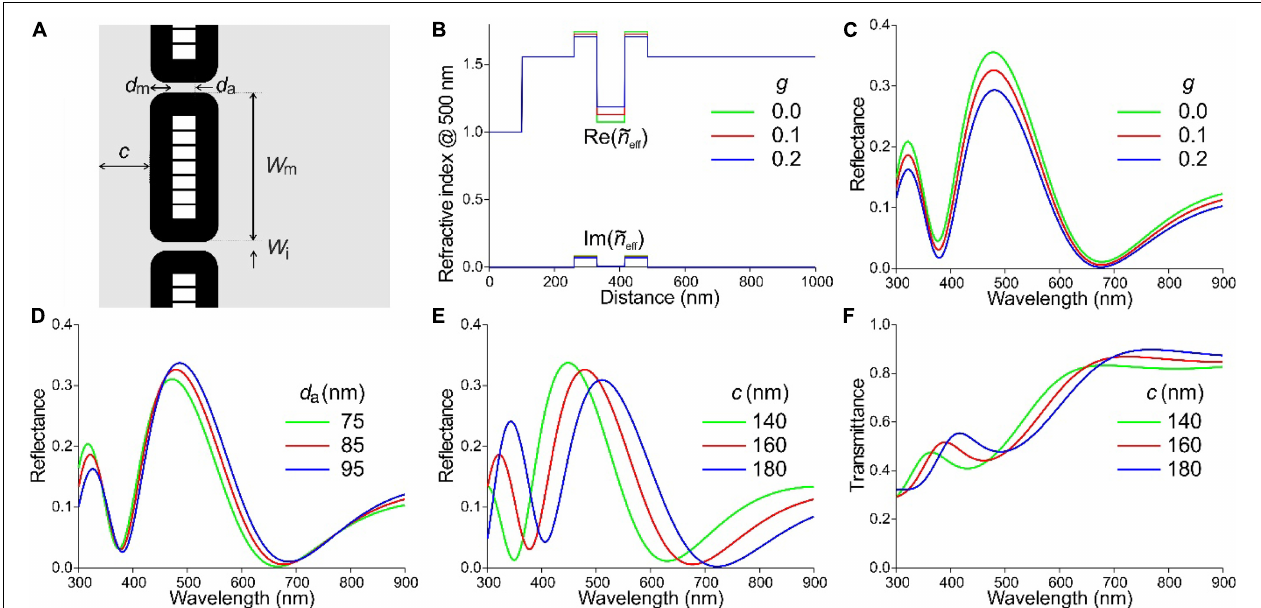
FIGURE 7 | Effective-medium-multilayer model of the L. nitens barbule anatomy. (A) Diagram of a barbule with cortex thickness c and hollow melanosomes with membrane thickness d m , air cavity thickness d a , width W m , separated from each other by a distance W i . (B) Real and imaginary refractive index profiles following from (A) ; for parameter values, see text. (C) Reflectance spectra resulting for a few values of the keratin filling factor of the melanosome layer, g . (D) Reflectance spectra resulting for a few values of the air cavity thickness. (E) Reflectance spectra resulting for a few values of the cortex thickness. (F) Transmittance spectra corresponding to (E)